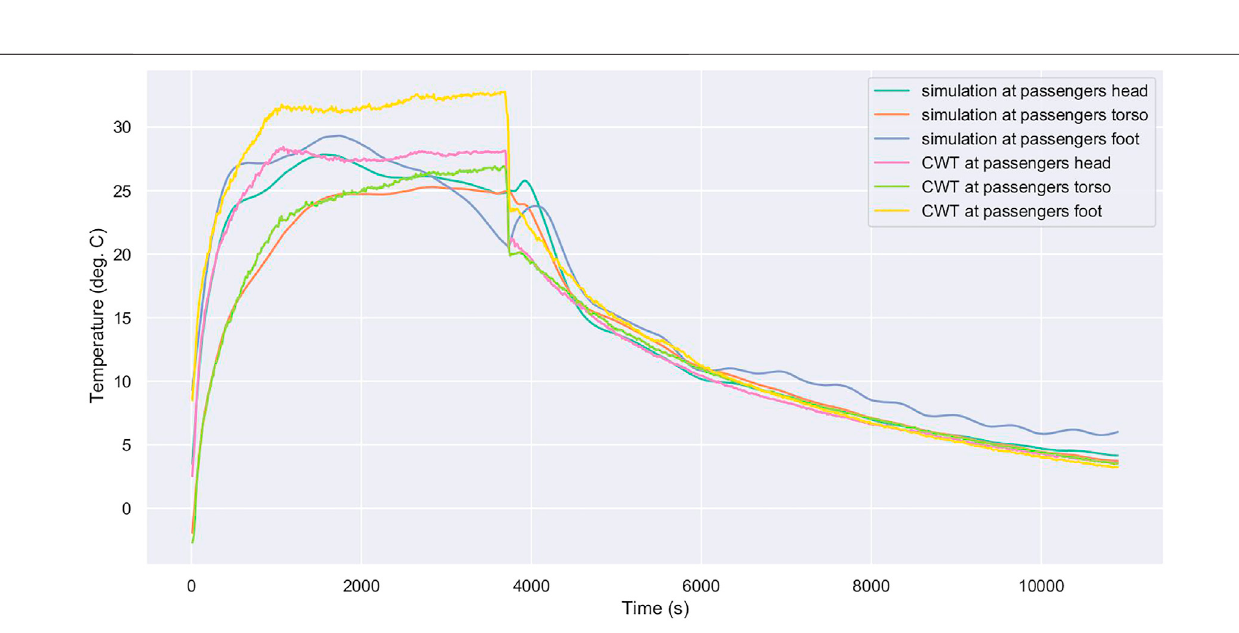
FIGURE 6 | ML-simulator correctly and independently tracks driver ’ s head, chest, and foot temperatures over a 3 h trial (CWT2) with only small errors. The trial settings are 22 ° C with vents set to neutral and recirculated distribution at 100 km h − 1 for 30 min, then switching to fresh distribution for 30 min, before switching all settings off for 120